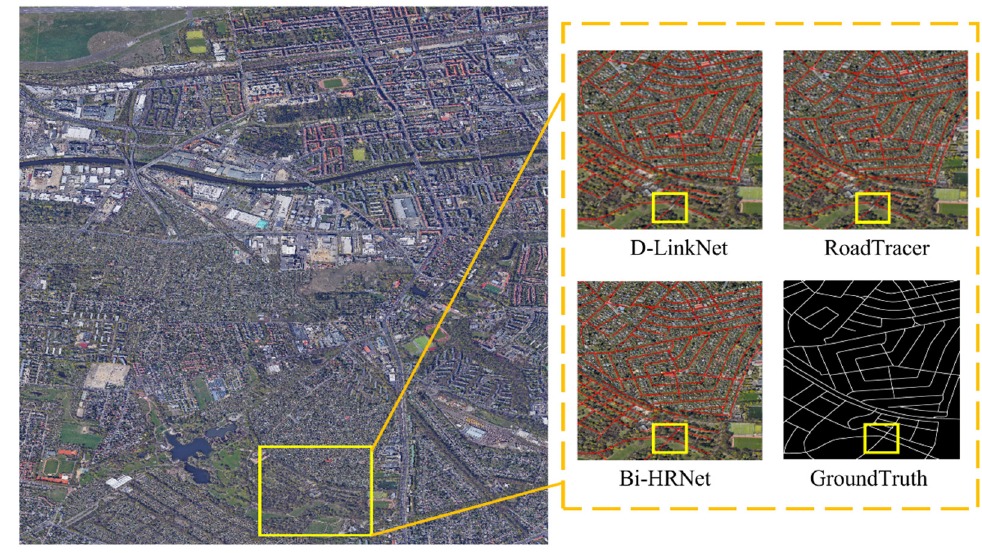
Figure 13. Visualization results of the proposed Bi-HRNet and previous methods on the constructed Google dataset. Table 3. Quantitative results of the proposed method and compared methods on the constructed Google dataset.